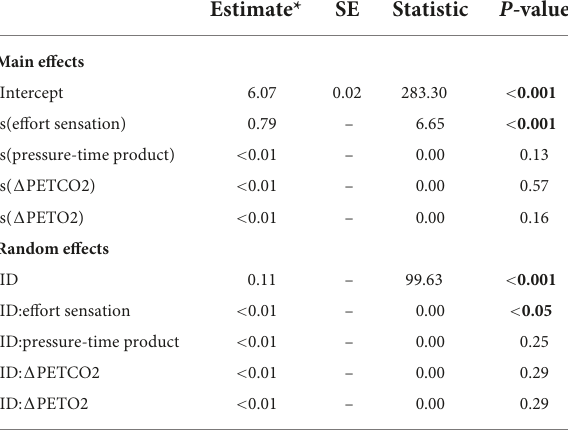
TABLE 3 Generalized additive mixed effects model (GAMM) results for total error rates during inspiratory loaded trials.